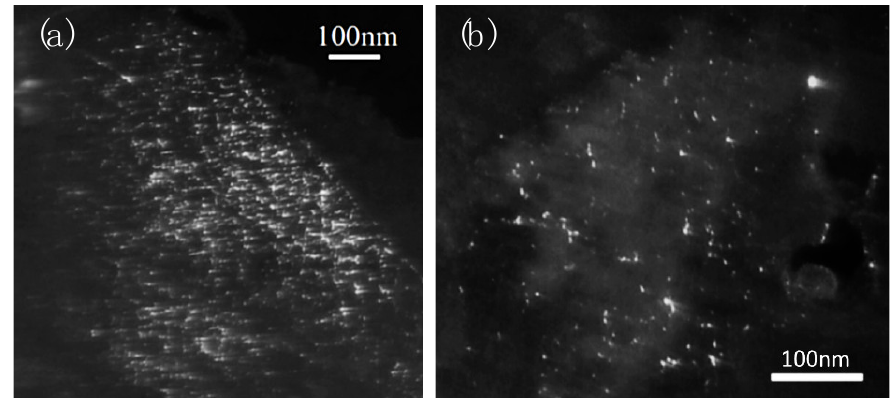
Figure 14. Thin foil transmission dark-field electron microscopy. ( a ) Orientation showing ε-carbide population appearing in all alloy variants after bake hardening treatment; ( b ) orientation showing NbC distribution in the 0.05% Nb microalloyed steel.